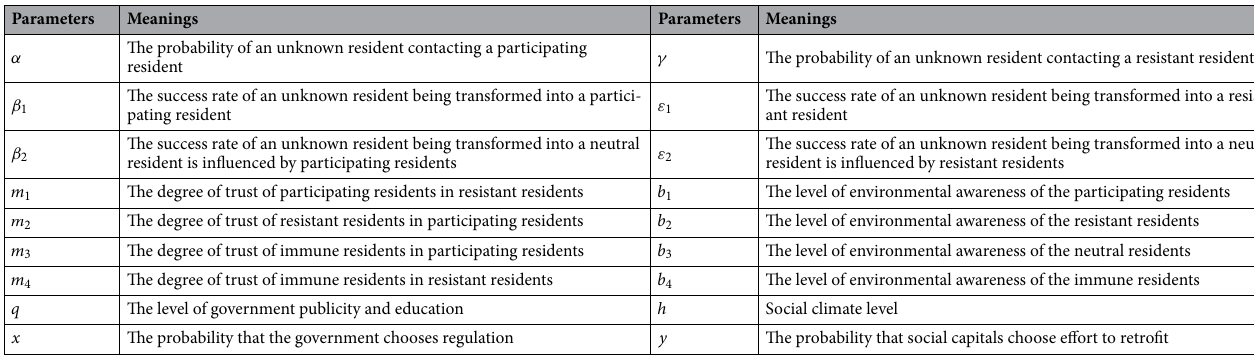
Table 1. Relevant parameters in the dissemination model.